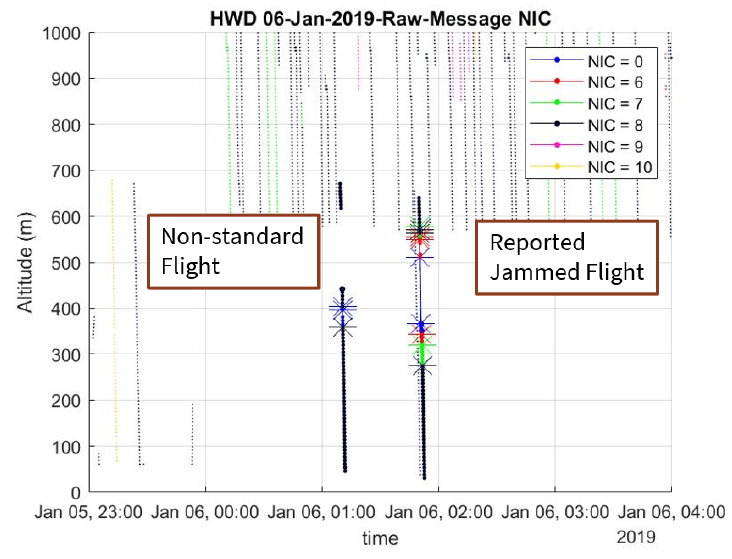
Figure 9. Altitude versus time plot for all flights passing target airspace on 6 January